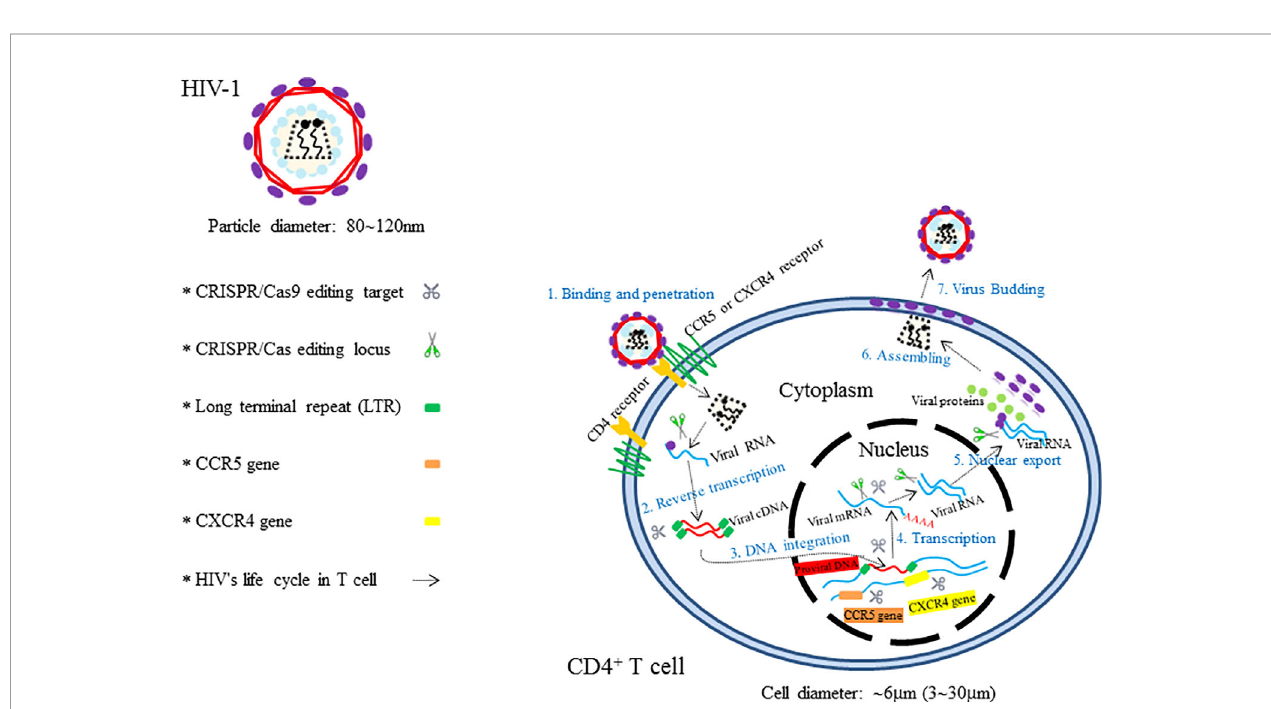
FIGURE 2 | The illustration showing HIV ’ s invasion paths in cells and the therapeutic targets of CRISPR/Cas9.